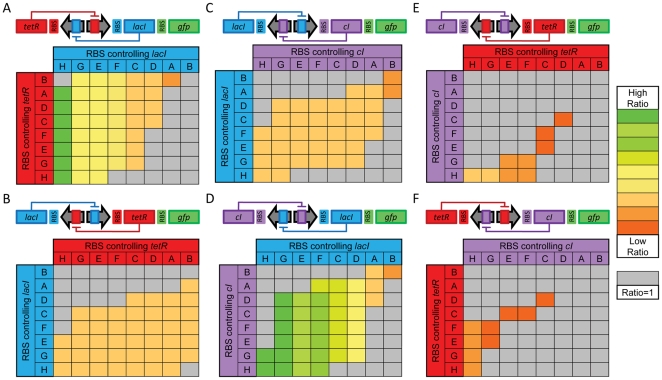
Mapping the behavior of 384 genetic constructs.Each section A to F indicates a different selection of repressors within a toggle switch: (A) tetR and lacI, (B) lacI and tetR, (C) lacI and cI, (D) cI and lacI, (E) cI and tetR, and (F) tetR and cI. Other networks that cannot give rise to bistability (e.g. a construct with tetR as both genes) are excluded as are designs that only vary the GFP RBS (see text). Each pair is explored by varying the RBS (ordered by translational efficiency from low (RBS H) to high (RBS B) as determined by a qualitative fit of the results of Gardner et al. [24] with consistent letter-based labels) and calculating the detectability ratio, defined as the steady state GFP concentration in the “on” state divided by the concentration in the “off” state. These ratios are displayed using a color map as indicated by the legend to the right. Monostable constructs have a ratio of 1 and are indicated by gray boxes. The ratio gives a measure of how easily the two steady states can be distinguished, which is important due to high experimental noise. Each pane also elucidates the traditional two-parameter bifurcation diagram of each gene pair as the translational rates are varied by changing RBSs. Constructs near the edge of the cusp operate near saddle-node bifurcations and are more prone to noise-induced switching. Thus, constructs from the cusp interior are preferred for robust behavior.